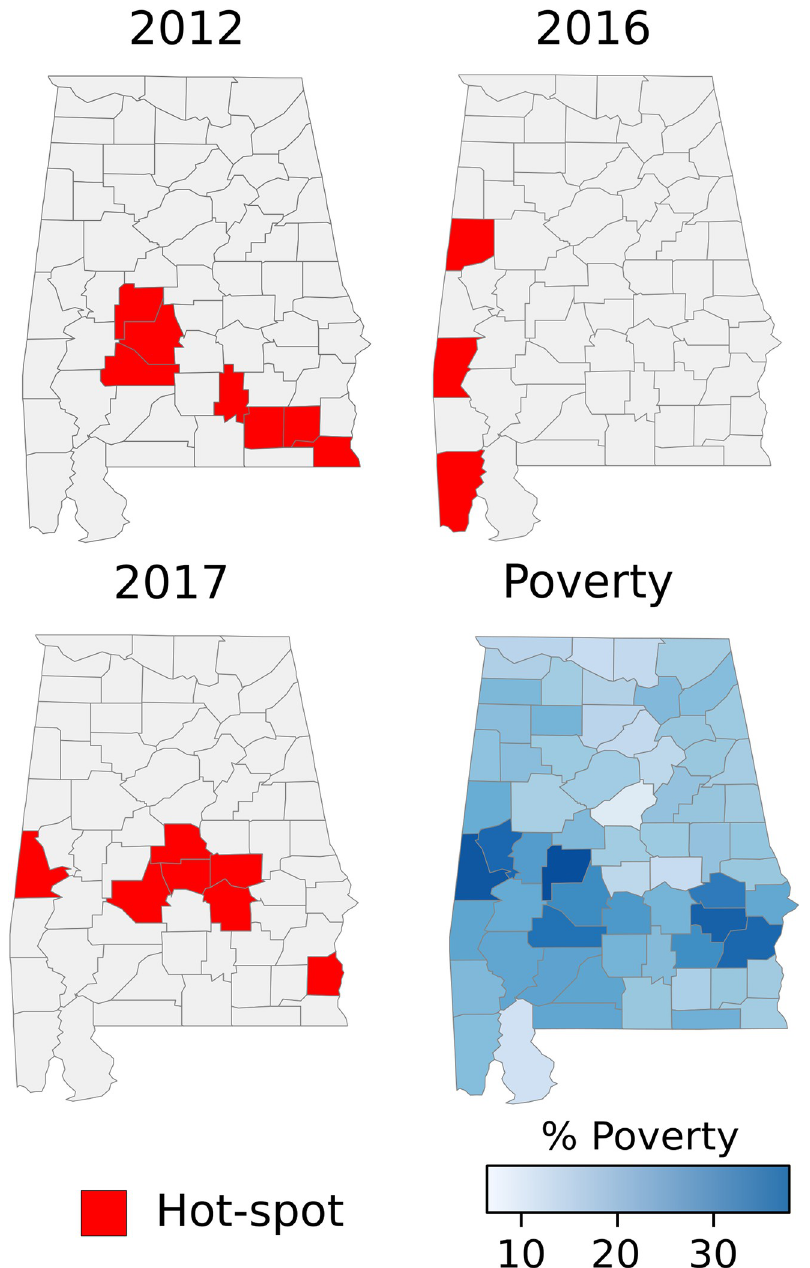
Fig 2. Hot-spots of WNV incidence at county level in Alabama in the years 2012 and 2017. The maps show the three years when outbreaks of WNV occurred. The figure also includes the percentage of the population living in low socio-economic status at the county level based on census data. The maps were created using public available county boundaries downloaded from www.usgs.gov processed with the R software [25]. fraction of population living under the poverty threshold, after controlling for population, flooding events, precipitation, and land use (Table 2). Specifically, this association was positive during the high circulation years (p < 0.05), but negative during 2008 (p < 0.05) (Table 2). Pov- erty was also positively associated with WNV incidence during 2007, although not